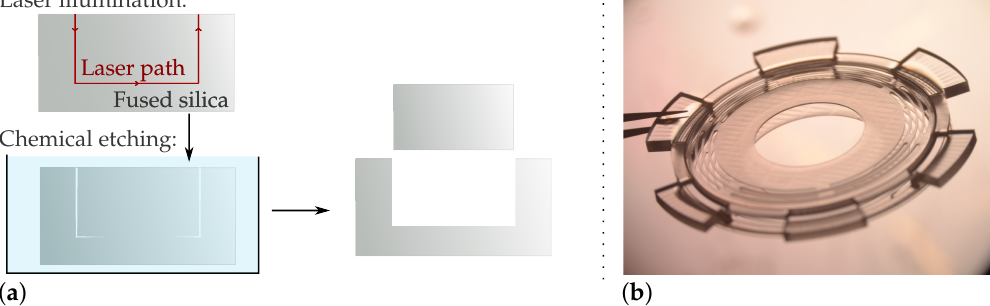
Figure 4. ( a ) Illustration of the subtractive printing process for fused silica. The fused silica was locally illuminated by a femtosecond laser, which increased its etching rate. By illuminating complete areas, blocks of material can be detached and the desired structure can be obtained. ( b ) Final prototype of the monolithic parallel ortho-planar springs after etching (outer radius: 10 mm, thickness of the springs: 0.144